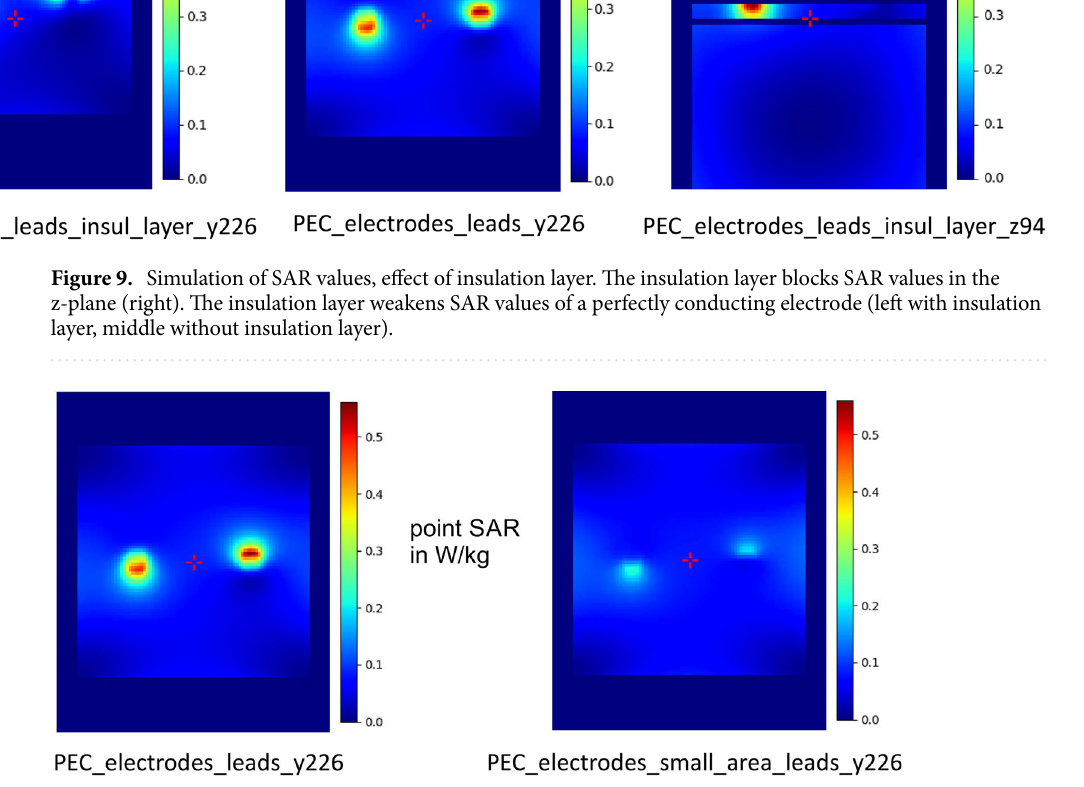
Figure 10. Simulation of SAR values for small area. If the leads of perfectly conducting electrodes span a small area, the SAR values are weaker. This simulation shows that the model makes correct assumptions.